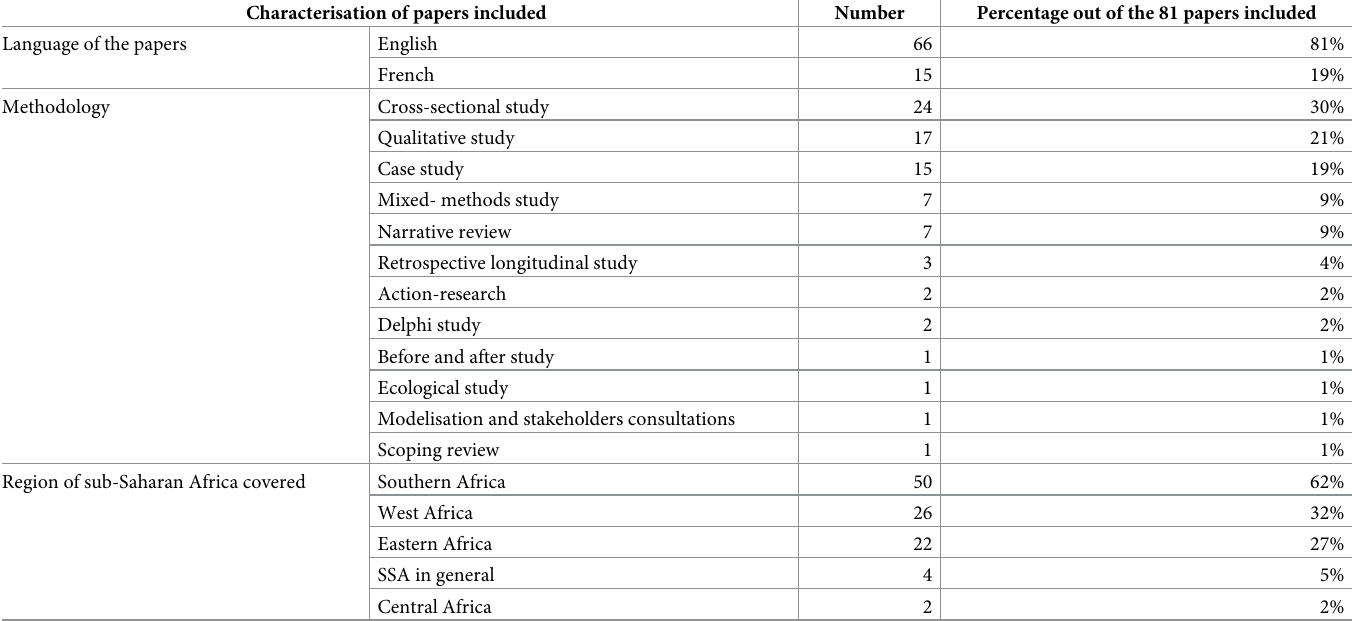
Table 2. Characterisation of the papers included.